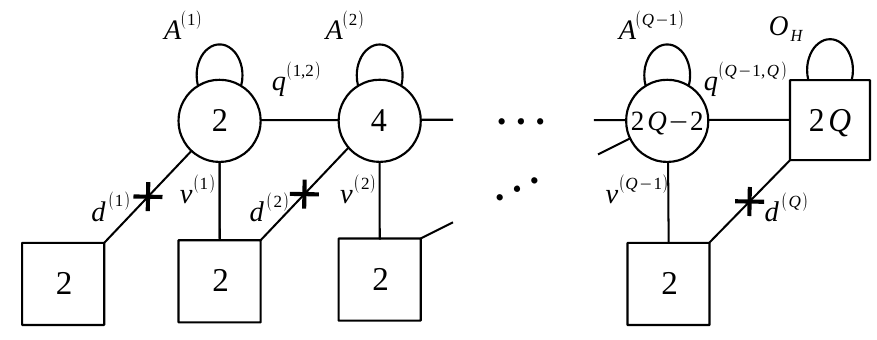
Figure 4: The quiver description for the F E [ USp ( 2 Q )] theory. Each node with a la- bel 2 n inside denotes a USp ( 2 n ) group, with circle nodes being gauge groups and square nodes being flavor groups. Lines connecting adjacent nodes represent chiral fields transforming under the associated symmetries. In particular, we have an anti- symmetric (with the trace part) chiral field A ( n ) at each gauge node, bifundamental chiral fields q ( n , n + 1 ) and fundamental chiral fields d ( n ) , v ( n ) . We also have additional gauge singlet chiral fields b represented by crosses in the above quiver and a set of n singlets collected in a matrix O H transforming in the traceless antisymmetric repre- sentation of the USp ( 2 Q ) flavor symmetry associated to the node at the end of the x